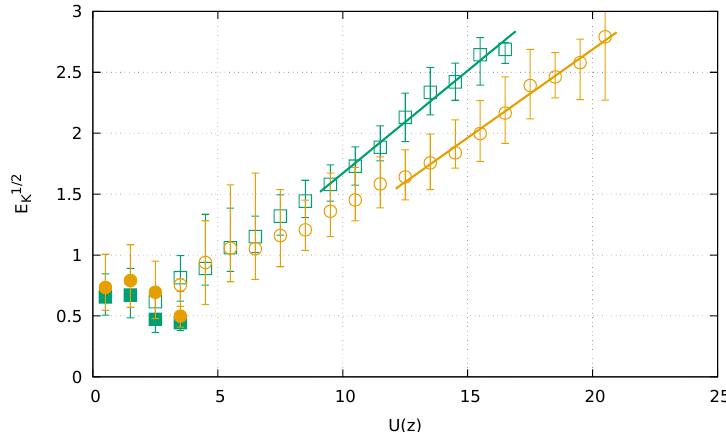
√ E K vs. U ( z ) , for 30 min averaging intervals. Symbols and colors as in Figure 7. Figure 8.